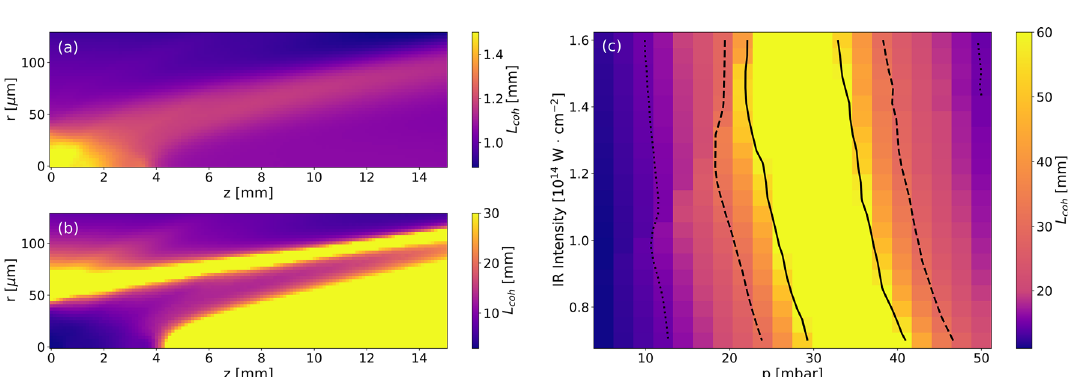
Figure 5. Spatial distribution of the coherence length L coh at the peak of the laser pulse for the 17th harmonic generated in 35 mbar of Kr with vacuum intensity of 0.9·10 14 W/cm 2 and vacuum focus positioned at the center of the medium. Pre-ionization of the medium was set to 0% ( a ) and 8% ( b ). ( c ) The on-axis coherence lengths after 15 mm propagation at the peak of the laser pulse as a function of the input-laser peak intensity and medium pressure. L coh = L med (dotted line), L coh = 2 L med (dashed line), and L coh = 4 L med (full